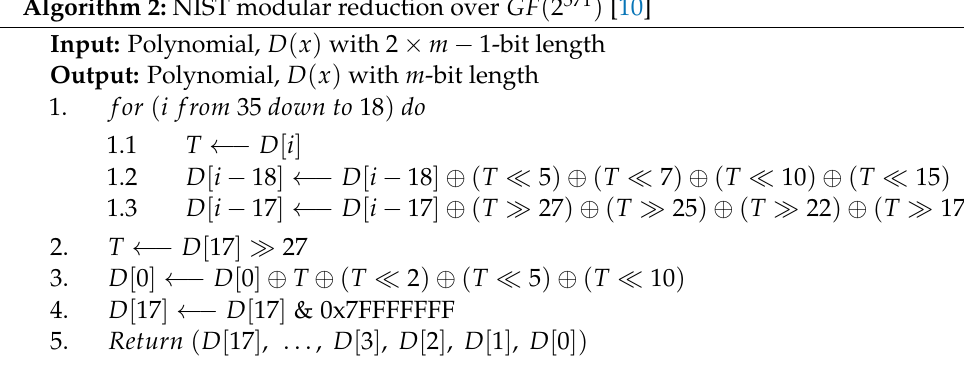
Algorithm 2: NIST modular reduction over GF ( 2 571 )